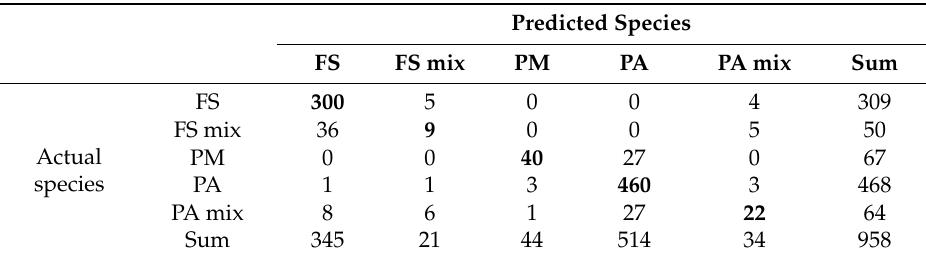
Table 4. Confusion matrix for three dominant tree species plus FS mix with conifers and PA mix with broadleaved, based on the most accurate Random Forest classification—summer and autumn mean band spectra with all features. FS—beech, PA—Norway spruce, PM—mountain pine. Predicted